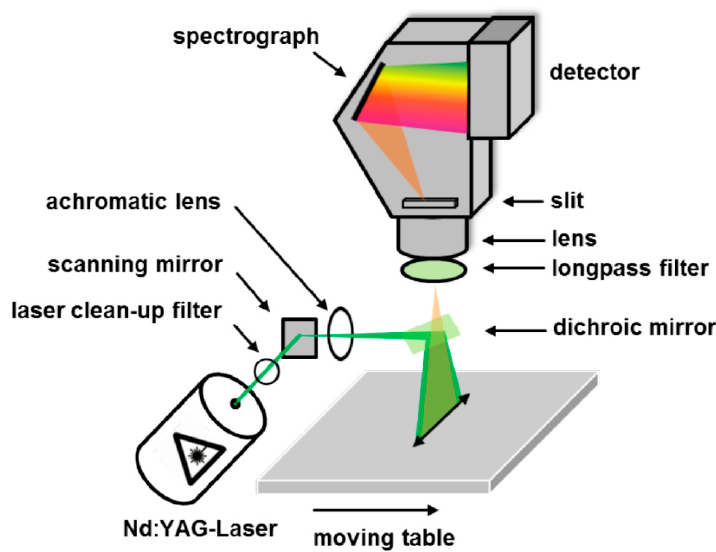
Figure 1. Schematic illustration of the developed laser hyperspectral imaging system (Laser-HSI) system .